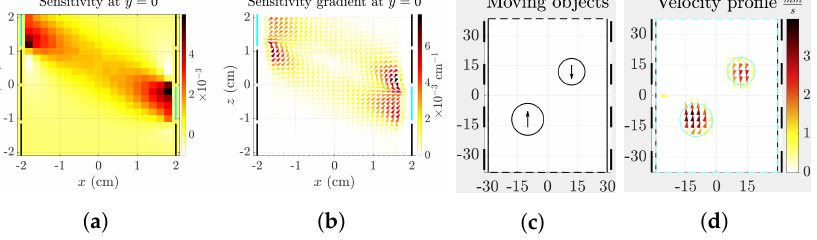
Figure 11. Sensitivity gradient based velocimetry. ( a ) Sensitivity distribution between a pair of electrodes. ( b ) Corresponding sensitivity gradient. ( c ) Simulation setup with moving objects with average velocity of 2 mm/s. ( d ) Reconstructed velocity